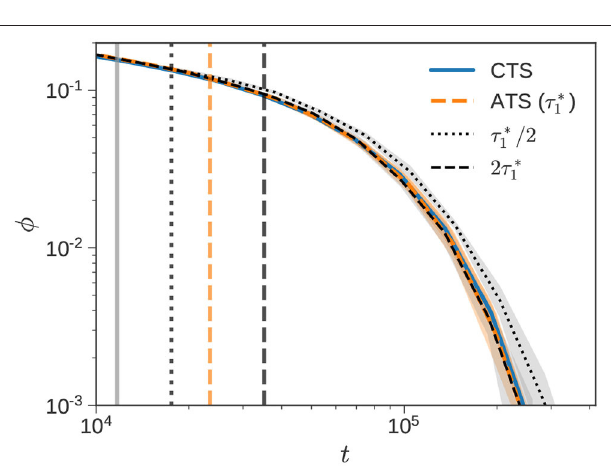
FIGURE 5 | Recalibration duration. Normalized stress relaxation of the bidisperse blend ( ¯ Z 1 = 10, ¯ Z 2 = 40) with w 1 = 0.50 reported in Figure 4B is zoomed into. The CTS (solid blue), ATS (dashed orange), and T s = τ ∗ 1 (vertical gray) lines are identical. The dotted and dashed black curves denote ATS simulations performed where T e is selected according to T e − T s = 0.5 τ ∗ 1 and 2 τ ∗ 1 , respectively. Vertical lines of the same kind mark T e . In the standard ATSA, T e − T s = τ ∗ 1 (dashed orange).